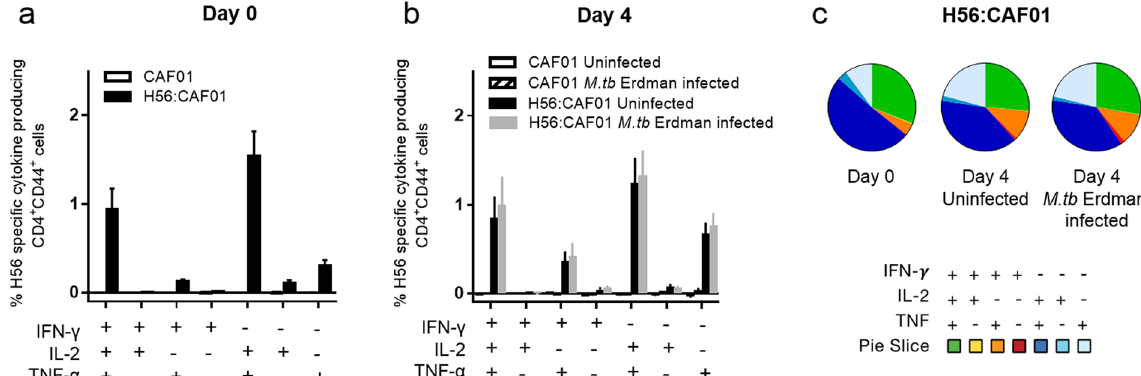
Figure 6. In vitro infection does not drive detectable change in T cell functionality. Groups of mice were immunised three times s.c. with 2-week intervals with H56 in CAF01 or adjuvant control (CAF01). One week after the last vaccination, splenocytes were isolated and used for intracellular cytokine analysis by flow cytometry at day 0 ( a ) or after four days culture with or without 50 CFU of M.tb Erdman ( b ). Splenocytes were stimulated with H56 in vitro before the frequencies of antigen-specific CD4 + cells (CD44 high ) producing IFN- γ , TNF- α and IL-2 were measured by gating for singlets, lymphocytes and live CD4 + cells. All possible combinations of cytokine expression were tabulated by Boolean gating analysis, and, after subtracting the background (non-stimulated) samples, the results for the seven combinations expressing at least one of the cytokines were shown. Bars represent mean + SEM of eight mice. ( c ) Pie charts over the polyfunctional CD4 + cells shown in Fig. 6a and b.